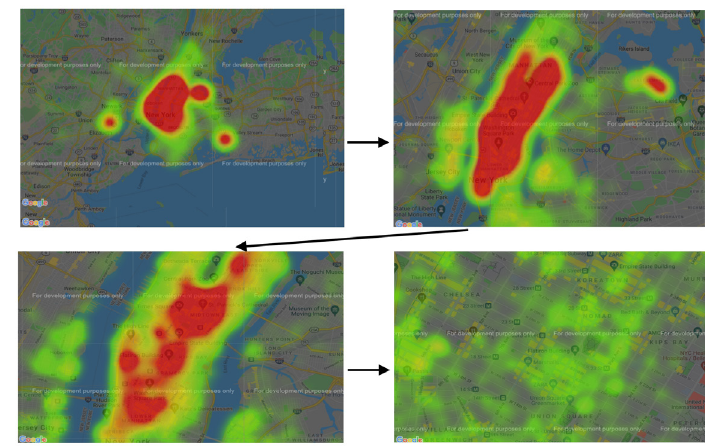
Fig. 2. Heat map of Uber travel density in New York city at different scale levels (Uber Heat Map, n.n,